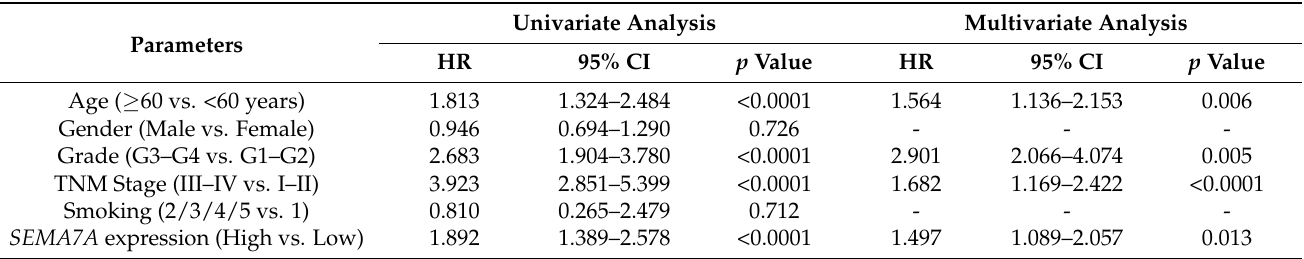
Table 1. The association between SEMA7A expression and the demographic and clinicopathological parameters of patients with primary KIRC in the TCGA. Parameters Sample (N = 533) SEMA7A mRNA Expression